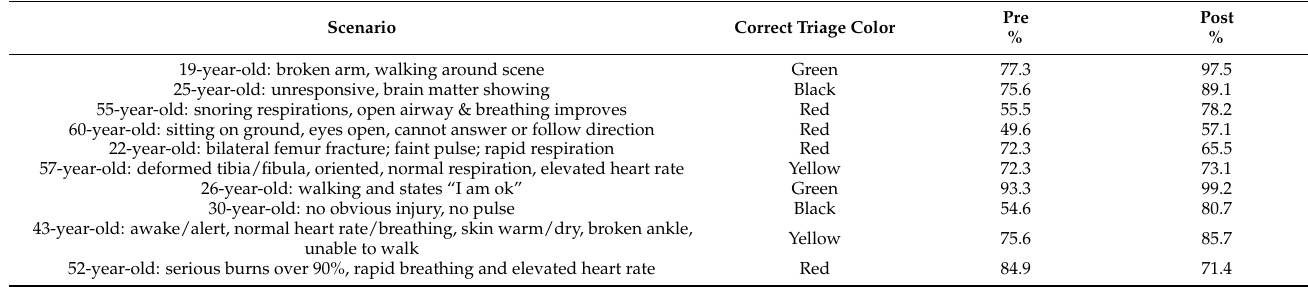
Table 3. Results from a Mass Casualty Simulation using a pre-post Simple Triage and Rapid Transport (START) quiz with interprofessional students November 2021. (n =